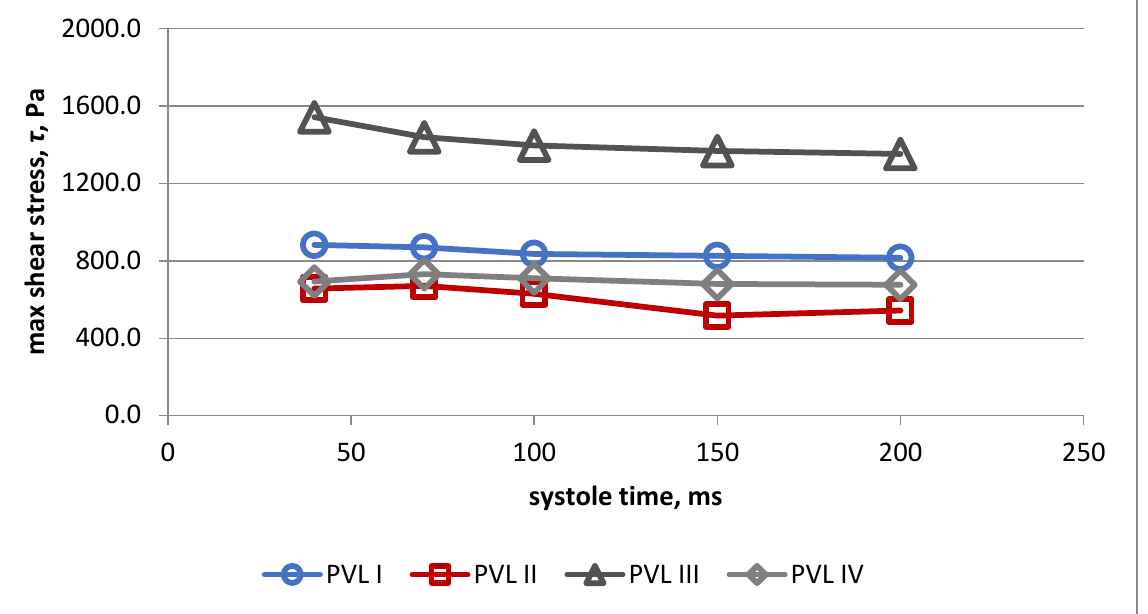
Figure 9. Maximal shear stress in fluid during systole for all PVL models. The changes in volume of the PVL channel, in which shear stress exceeded 300 Pa during systole for all PVL models, is presented in Figure 10. Almost identical values were obtained for models I, III and IV, whereas significantly lower values were observed in the case of model